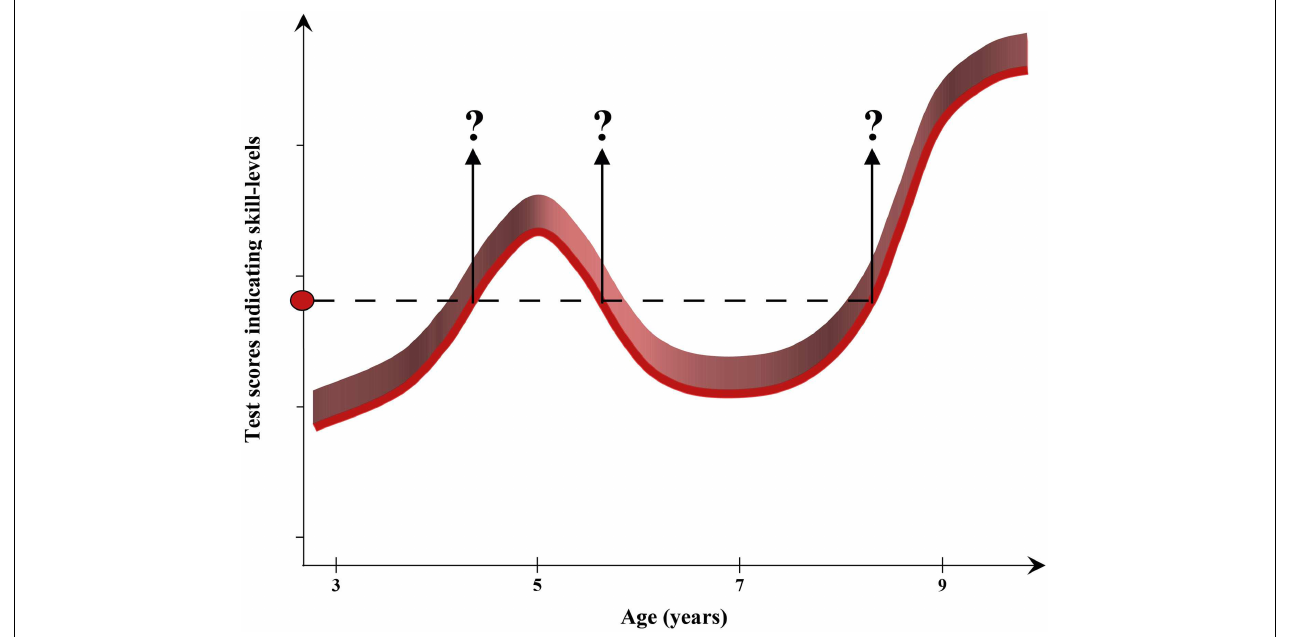
FIGURE 2 | Example for a U-shaped development: the marked skill-level is achieved at three different ages .